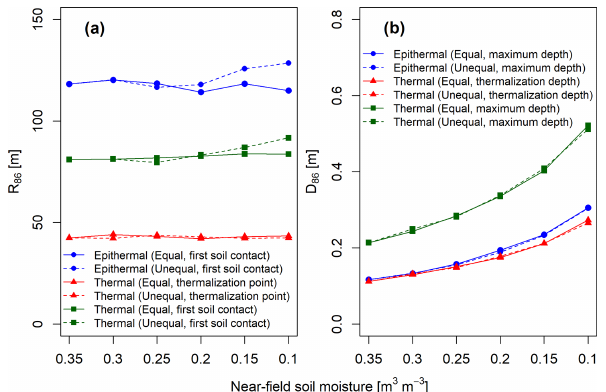
Figure 6. The simulated measurement footprint radius R 86 (a) and depth D 86 (b) of thermal and epithermal neutrons when soil mois- ture in areas with mineral and peatland soils decreases by the same amount (solid lines) and when peatland soil moisture decreases twice as much (dashed lines).